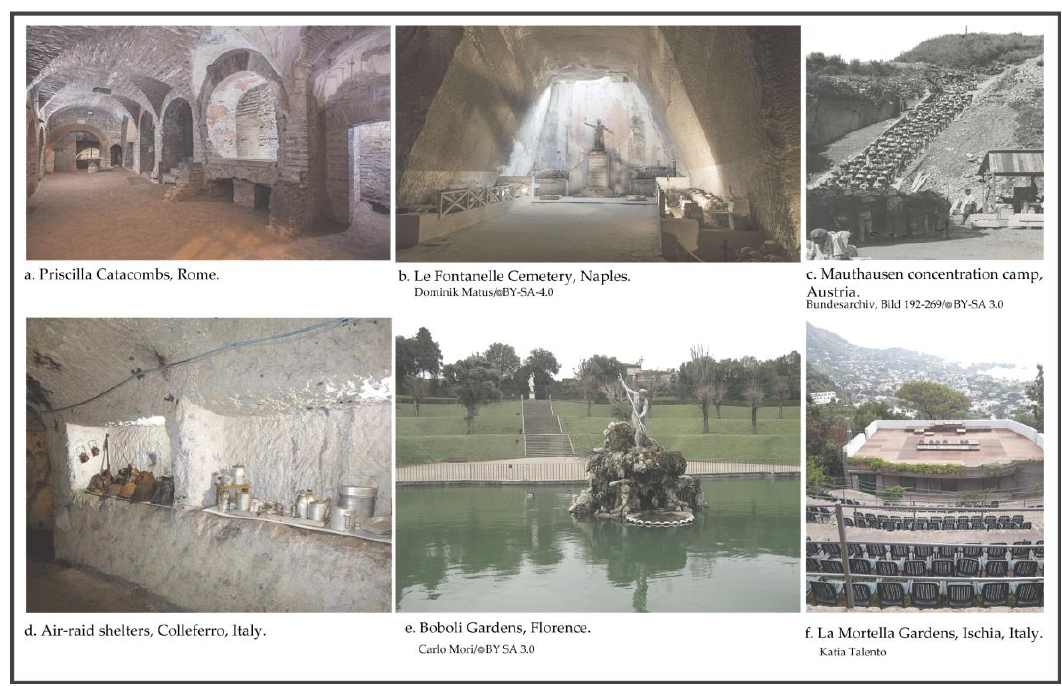
Figure 1. Ancient examples of quarry reuse.